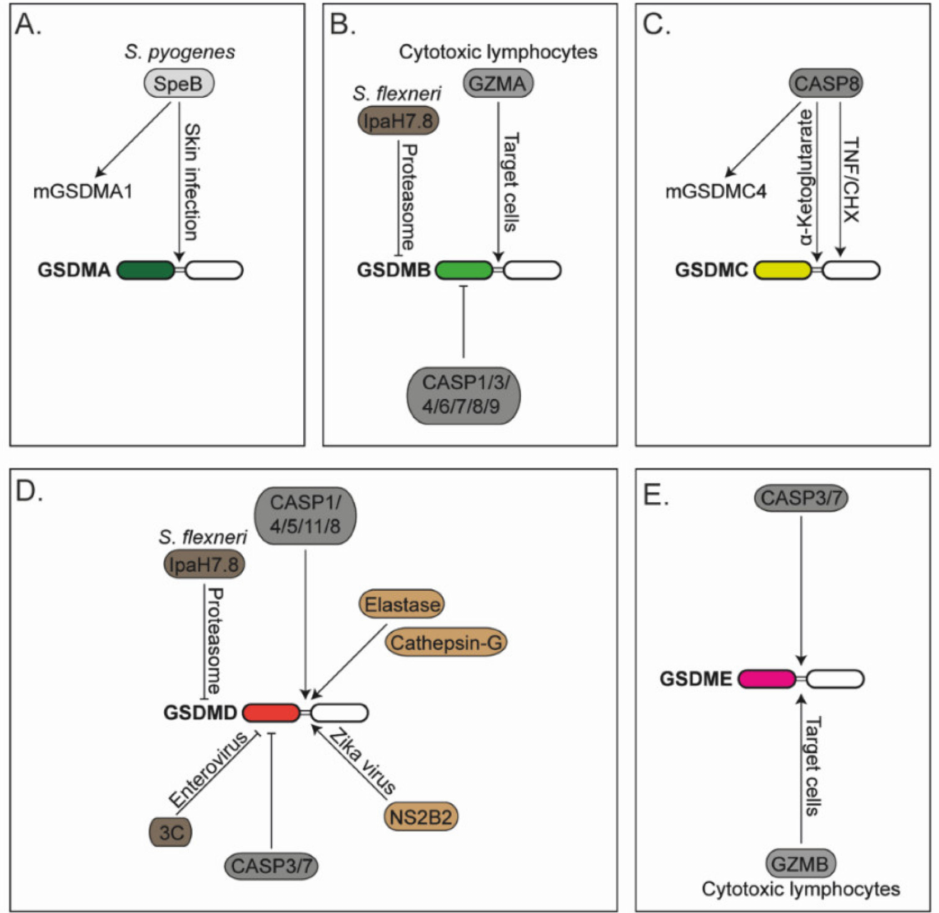
Figure 1. Regulation of gasdermins: ( A ) Human gasdermin-A (GSDMA) and murine GSDMA1 are cleaved by the cysteine protease SpeB from Streptococcus pyogenes ( S. pyogenes ) during skin infection. ( B ) Gasdermin-B (GSDMB) is cleaved by granzyme-A (GZMA) delivered by cytotoxic lymphocytes. GSDMB is cleaved and inactivated by recombinant caspases-1/3/4/6/7/8/9 (CASP1/3/4/6/7/8/9). IpaH7.8 effector protein from Shigella flexneri ( S. flexneri ) ubiquitinates GSDMB that triggers its degradation via the proteasomal pathway. ( C ) Human gasdermin-C (GSDMC) and murine GSDMC4 are cleaved by caspase-8 (CASP8) in cells treated with tumour necrosis factor (TNF) and cycloheximide (CHX) or cells stimulated with α -ketoglutarate. GSDMC is cleaved at two different sites by CASP8. ( D ) Gasdermin-D (GSDMD) is cleaved by caspases-1/4/5/11/8 (CASP1/4/5/11/8), neutrophil protease elastase, cathepsin-G and NS2B2 from Zika virus. GSDMD is cleaved and inactivated by caspases-3/7 (CASP3/7) and the viral protease 3C from enteroviruses. The IpaH7.8 effector protein from S. flexneri ubiquitinates GSDMD that triggers its degradation via the proteasomal pathway. ( E ) Gasdermin-E is cleaved by CASP3/7 and granzyme-B (GZMB) derived by cytotoxic